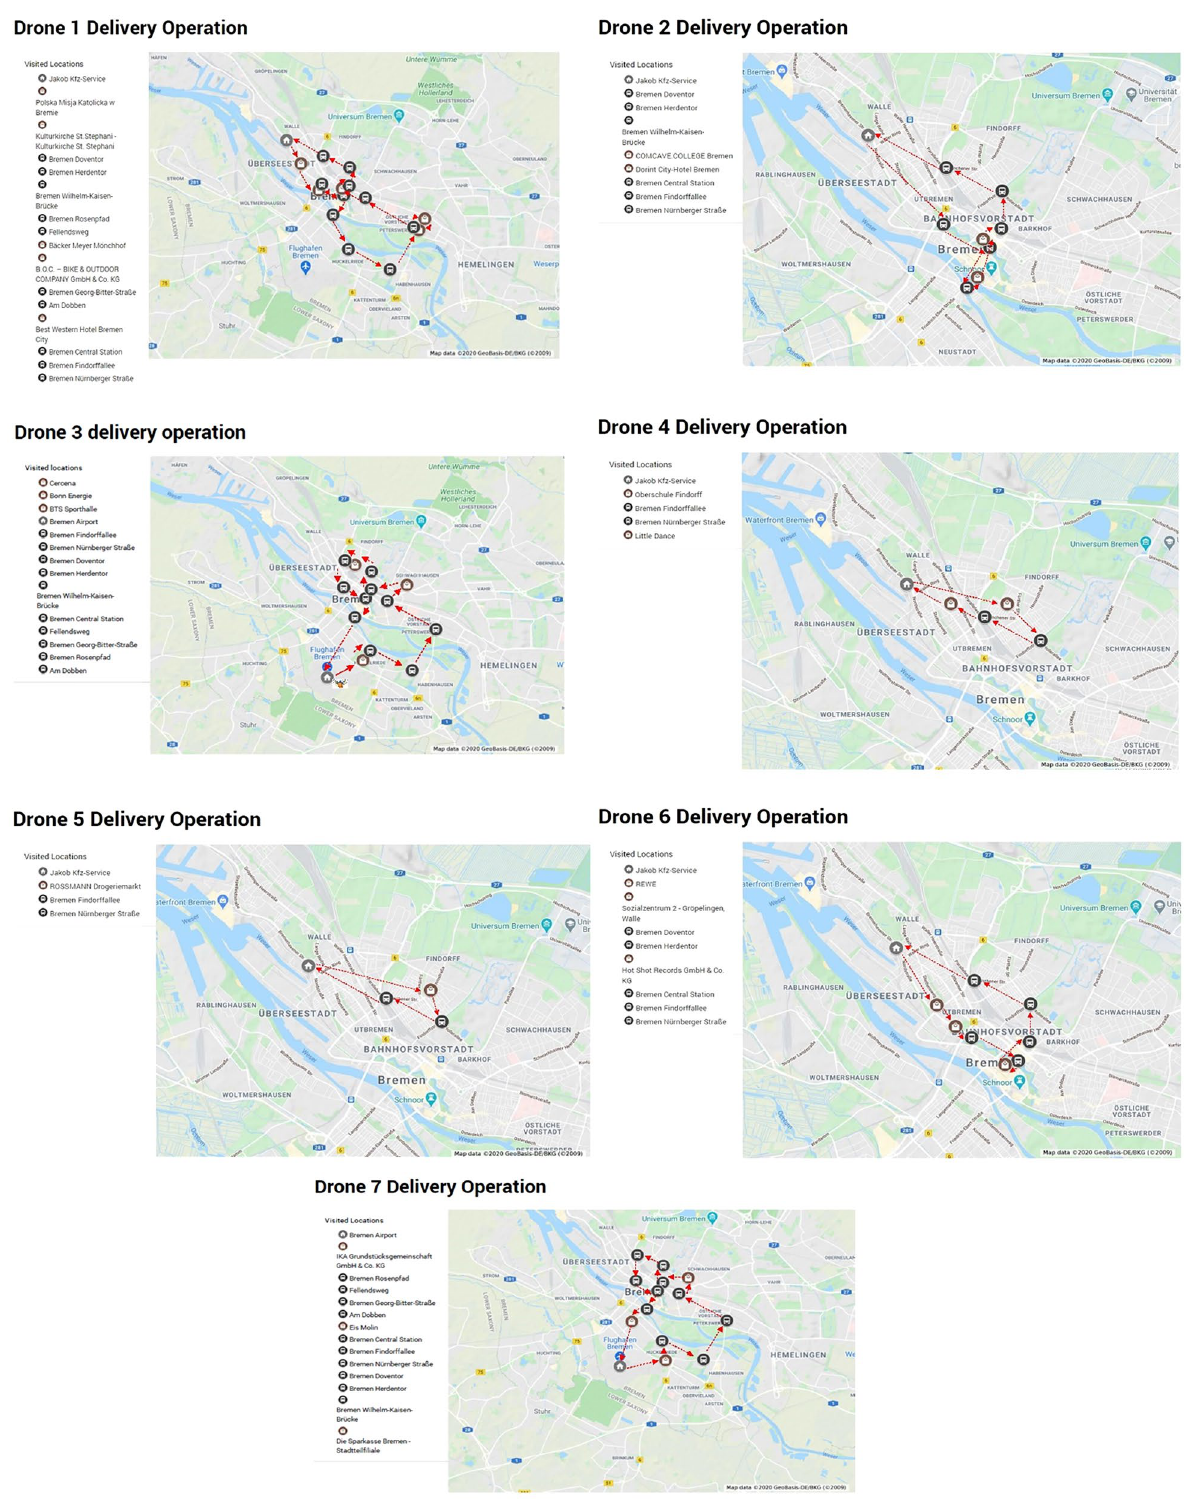
Figure 4. The best routing to deliver the